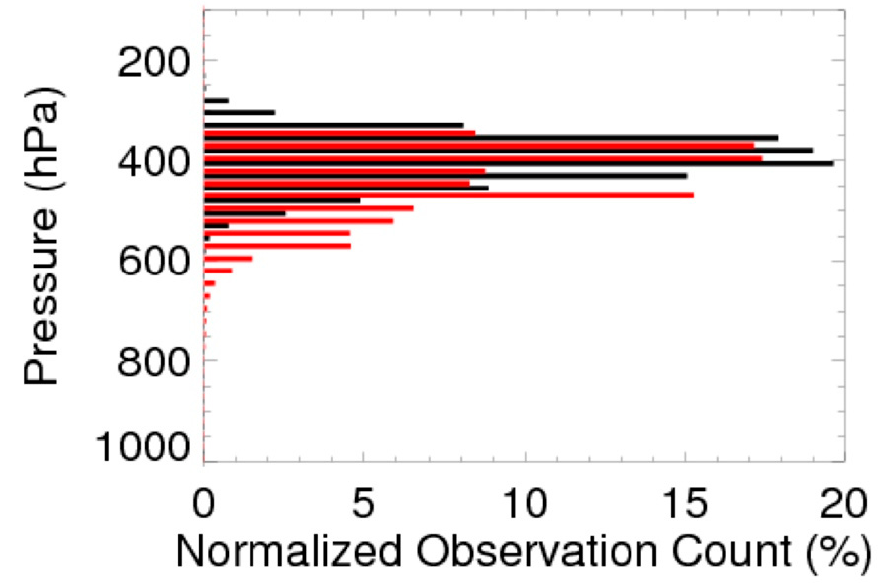
Figure 14. Vertical histogram showing the normalized observation counts per 6-h assimilation cycle for MODIS (black) and AIRS (red) water vapor AMVs. These are for all AMVs in the GEOS assimilation system before thinning or quality control, every six hours from 0000 UTC 1 May 2015 to 1800 UTC 31 Jul 2015.